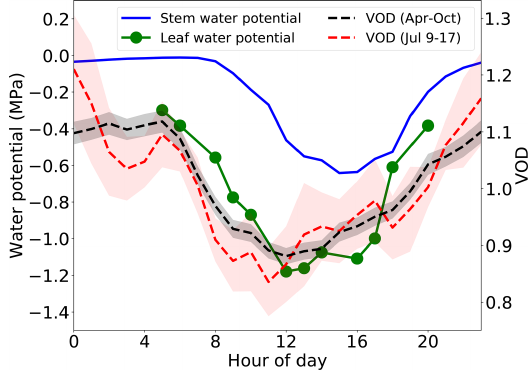
Figure 4. Average diurnal cycles of VOD and plant water potential. Shaded area is a range of 1 standard error for VOD.